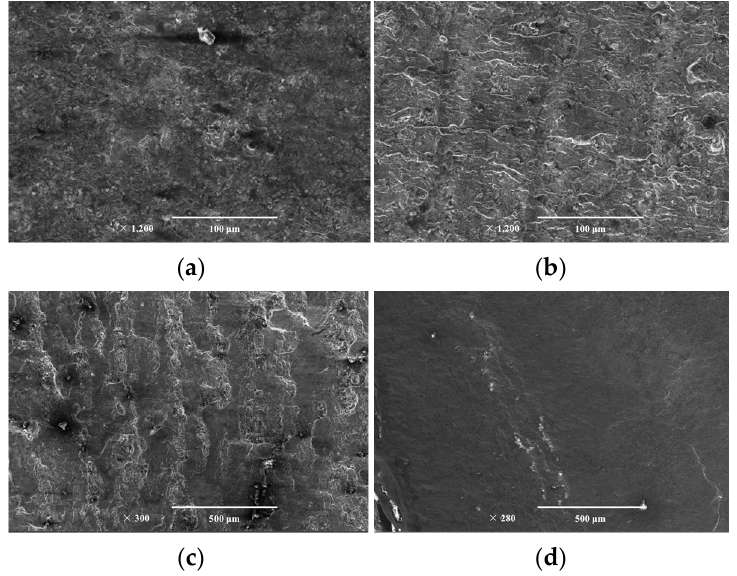
Figure 4. Boom fracture microscopy. ( a ) Early-term propagation area; ( b ) Mid-term propagation area fatigue beach marks and fatigue striations; ( c ) Late-term propagation area fatigue beach marks and fatigue striations; ( d ) Characteristics of the transient fracture zone of the dimple.